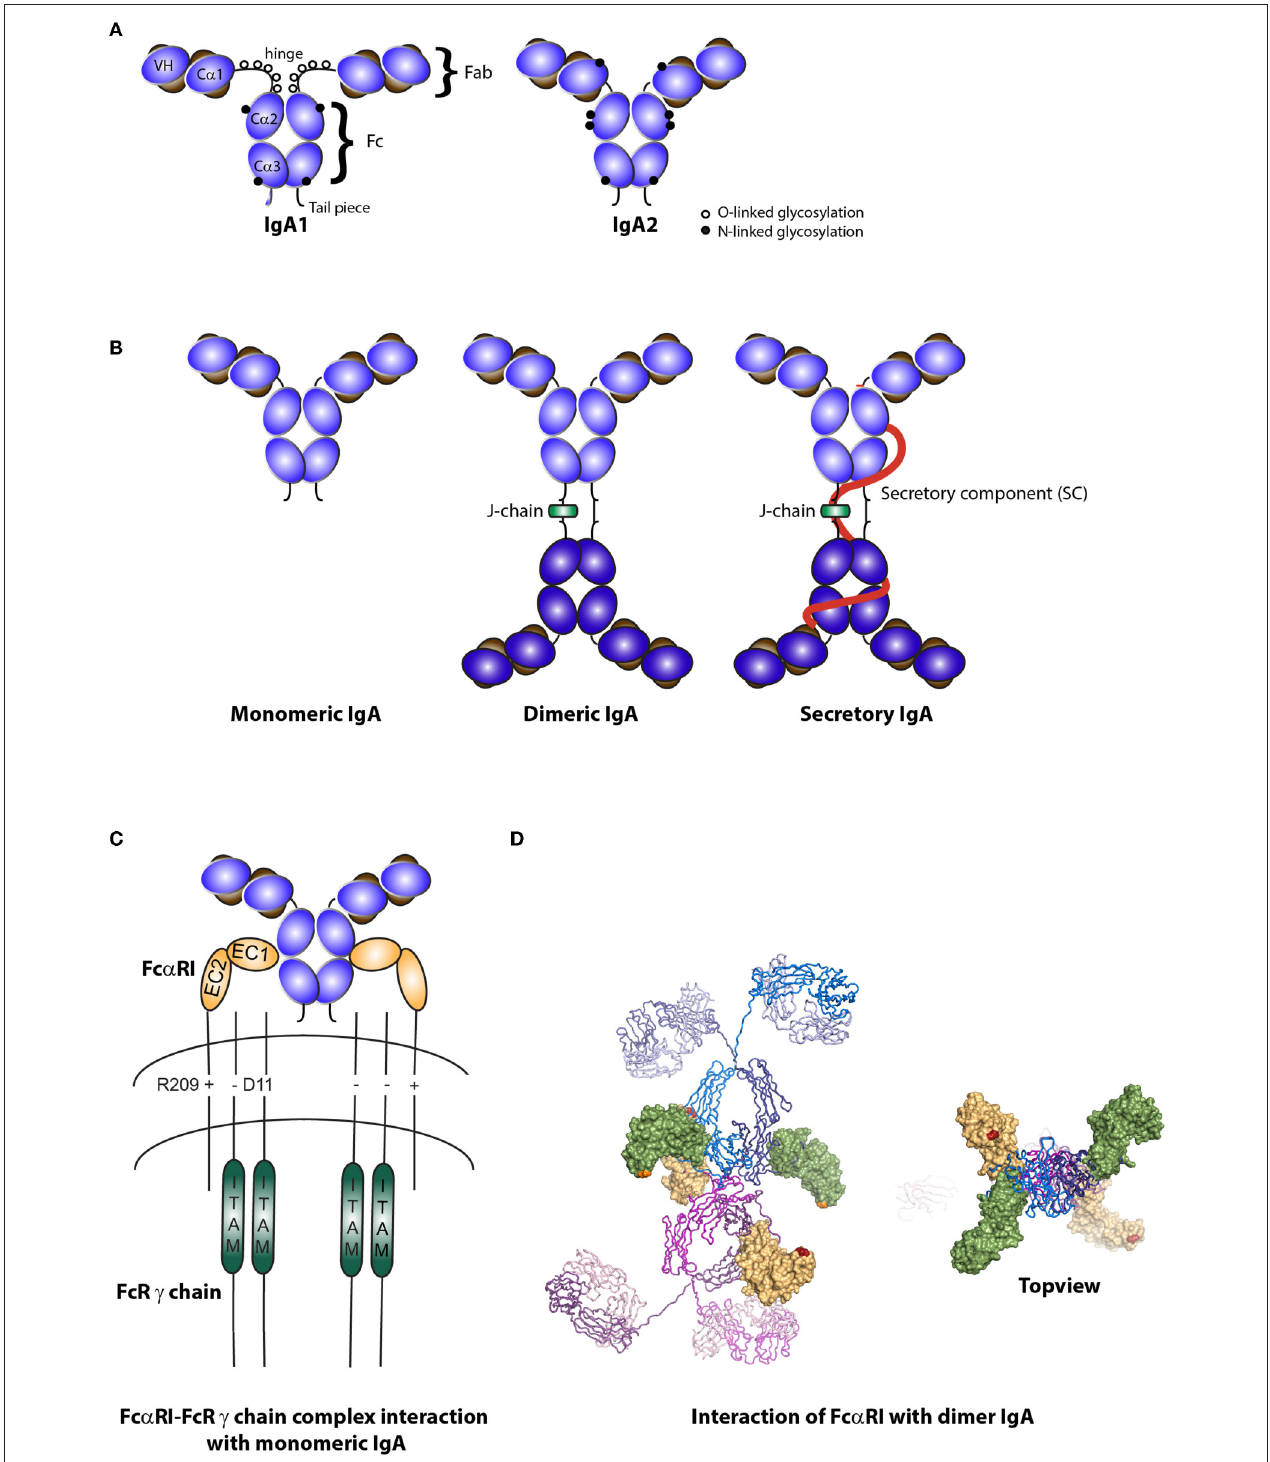
FIGURE 1 | Structure of IgA isotypes and the IgA Fc receptor (Fc α RI). (A) IgA1 vs. IgA2. IgA consists of two heavy chains (blue), each composed of three constant regions and one variable region, and two light chains (brown) that consist of one constant and one variable region. IgA1 contains a hinge region with O-linked glycosylation. (B) Monomeric, dimeric IgA, and secretory IgA. Dimeric IgA consist of two IgA molecules that are linked with a J-chain (green). Secretory IgA contains an additional molecule, the secretory component (SC; red). (C) Structure of Fc α RI. Fc α RI consist of a transmembrane domain, a short cytoplasmic tail and